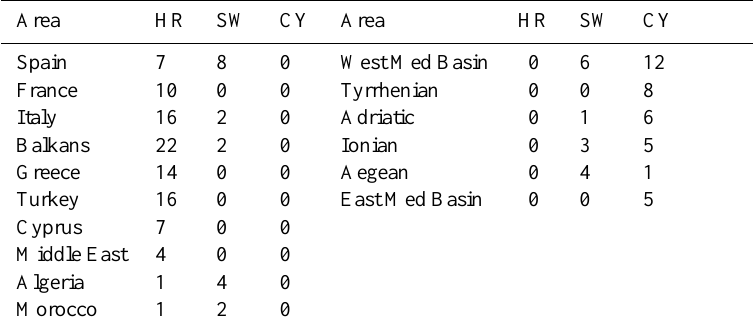
Fig. 1. Example of the DTS procedure applied during the DTS-MEDEX-2009 campaign: case 1120 selected on 2 December 2009. ECMWF ensemble MSLP mean (contours, hPa) and spread (shaded, hPa) forecasts for T+72, verifying time (VT), 5 December 2009 at 00:00 UTC. The phenomenon of interest is an intense cyclone, centred in Southern Italy, and likely producing heavy rain in the Balkan area and strong wind in the Western Mediterranean and the Tyrrhenian. The selected verifying area (VA) is indicated by a brown box. Table 1. Geographical distribution of the 89 (simplified) selected